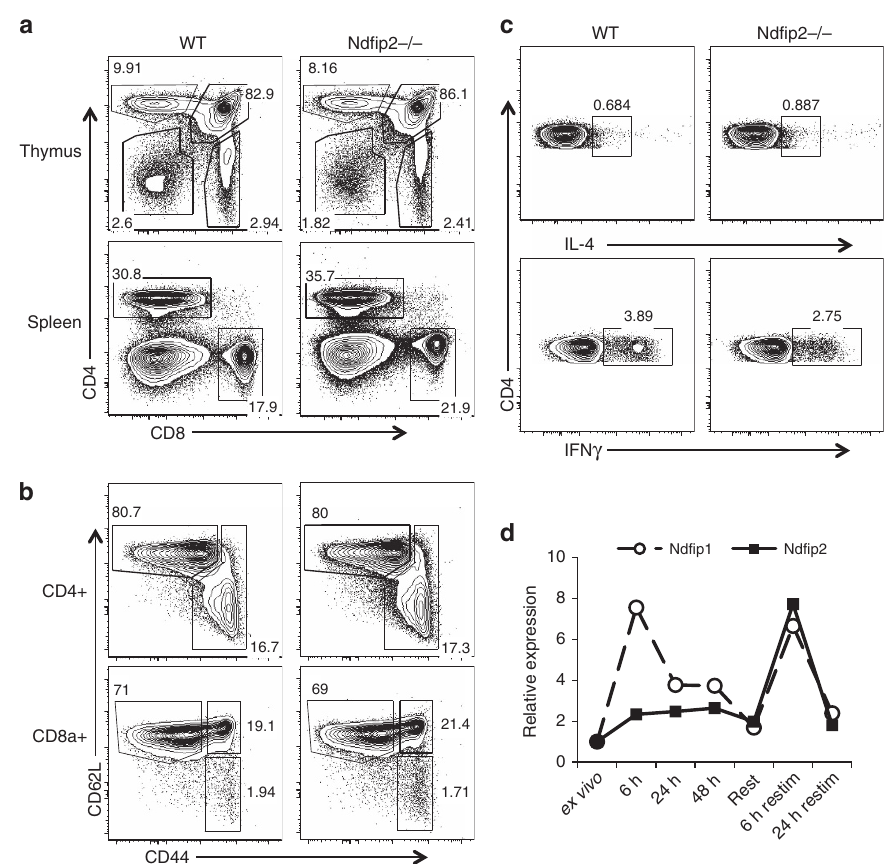
Figure 1 | Ndfip2 (cid:2) / (cid:2) mice do not show signs of inflammation. ( a , b ) Representative flow cytometry analysis of T-cell populations from thymus and spleen of 5–7-week-old Ndfip2 (cid:2) / (cid:2) and age-matched control mice: ( a ) CD4 þ and CD8 þ cells, ( b ) CD44 and CD62L expression on these cells, as noted. ( c ) Intracellular cytokine staining for IL-4 and IFN g in CD4 þ Tcells from Ndfip2 (cid:2) / (cid:2) and WTspleens stimulated ex vivo with PMA and ionomycin in the presence of BFA. Representative of at least five mice per genotype, 5–7 weeks of age. ( d ) CD4 þ Tcells were stimulated in vitro for the indicated time periods with a CD3/CD28. Ndfip1 and Ndfip2 expression was analysed by qPCR. Ndfip1/Ndfip2 expression relative to Actb was normalized to expression in unstimulated CD4 þ T cells. Representative of a minimum of three independent